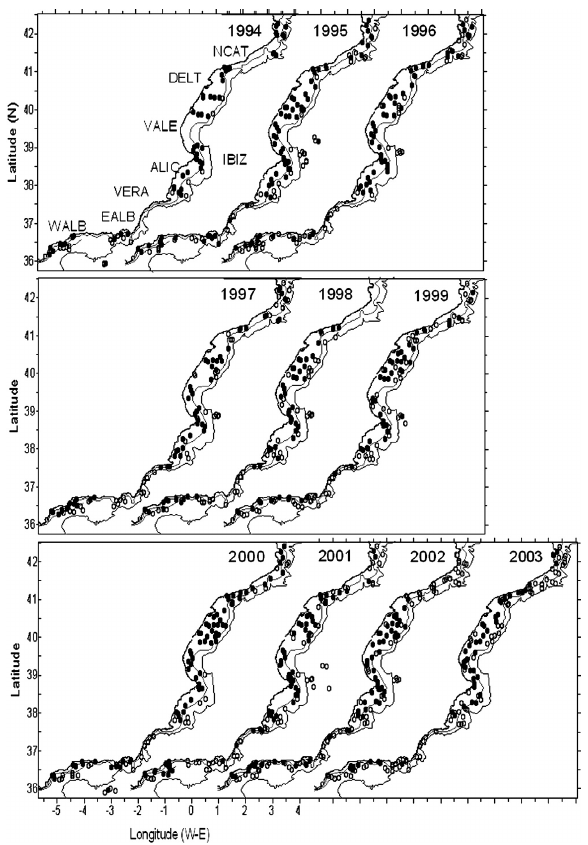
F IG . 1. – The position of trawls showing the presence (black circles) and the absence (empty circles) of Liocarcinus depurator in trawls throughout the study area from 1994 to 2003. The longitude scale refers directly to 1994, 1997 and 2000 outlines only. Contour lines represent depths of 200 and 1000